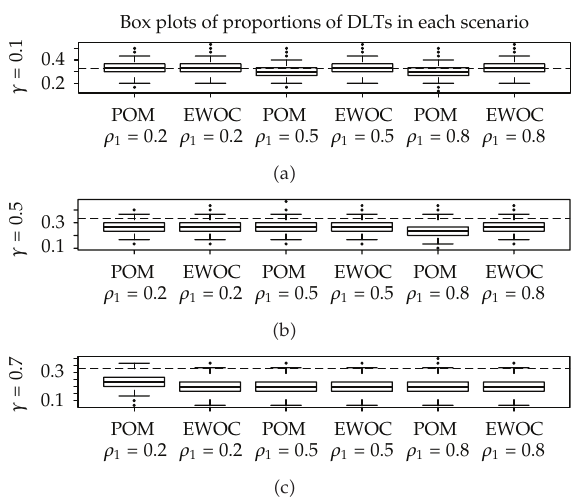
Figure 4: Box plots for the proportion of DLTs for EWOC-POM and EWOC under the nine scenarios. Each box plot was constructed from the DLT rates of the 1000 simulated trials. The dashed horizontal line corresponds to the target probability of DLT θ (cid:7) 0 .